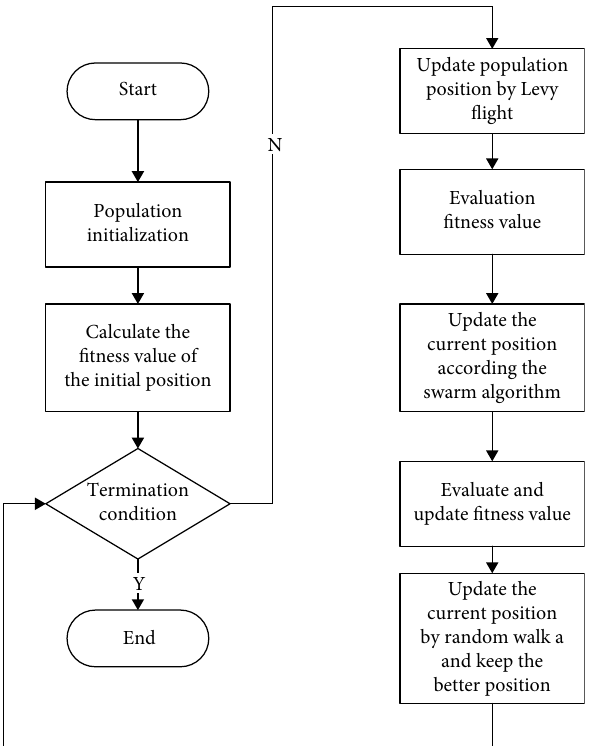
Figure 1: Flow chart of Levy fl ying bee colony